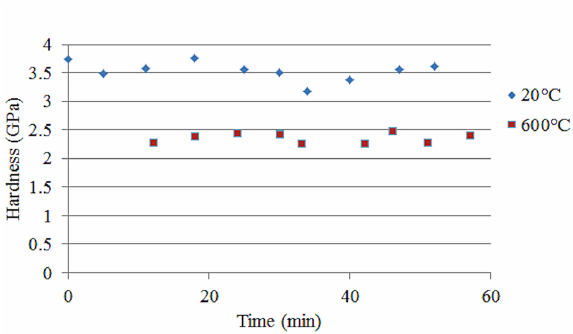
Figure 6. Validation of the method at 600 ◦ C and 150 g load on a new